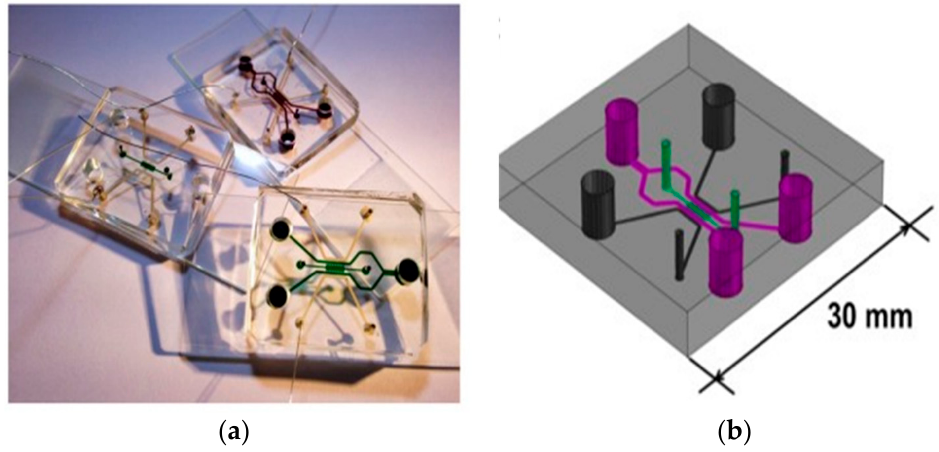
Figure 4. Microfluidic device with embedded contactless electrodes for the investigation of the effects of tumor-treating fields on cancer cells in a 3D extracellular-matrix-like hydrogel ( a ) and the 3D CAD overview ( b ) [40]. (Copyright: Creative Commons CC BY. 2016, Pavesi et al.).